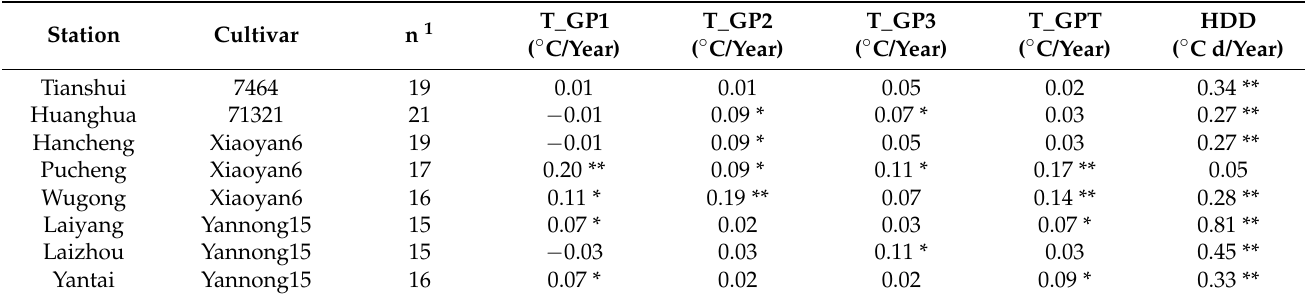
Table 2. Temporal trends of average temperature during the different growth periods of winter wheat and total heat degree-days from anthesis to maturity at the study